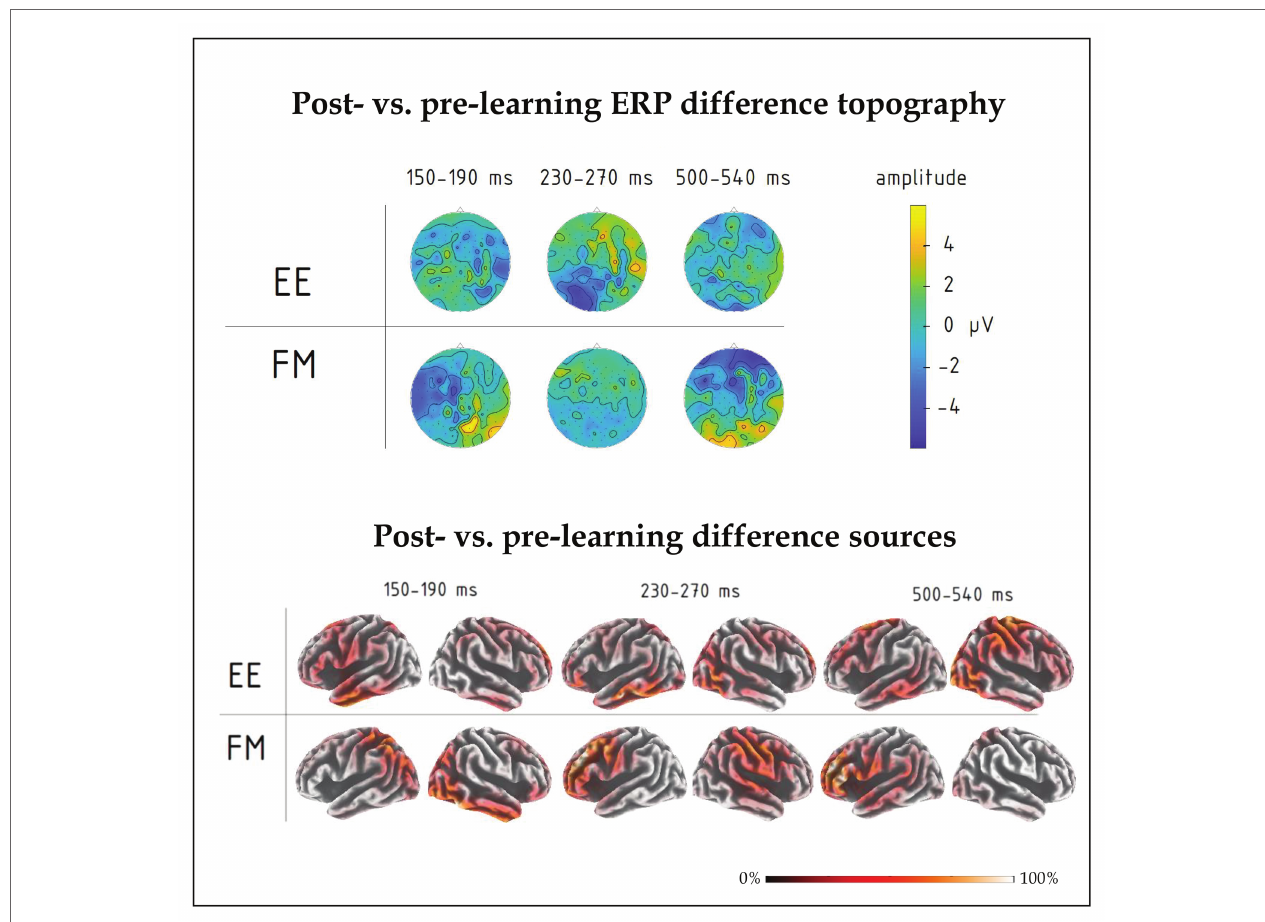
FIGURE 5 | (top) Post-learning vs. pre-learning response difference topography of group-average ERPs in the 150–190, 230–270, and 500–540 ms intervals for FM and EE conditions. While all three time windows indicated overall learning effects, significant interactions involving learning type were found in the first and third intervals. (bottom) Distributed source solutions (eLORETA) for group-average post‐ vs. pre-learning difference ERPs for FM and EE conditions at the three main peaks, left-hemispheric and right-hemispheric